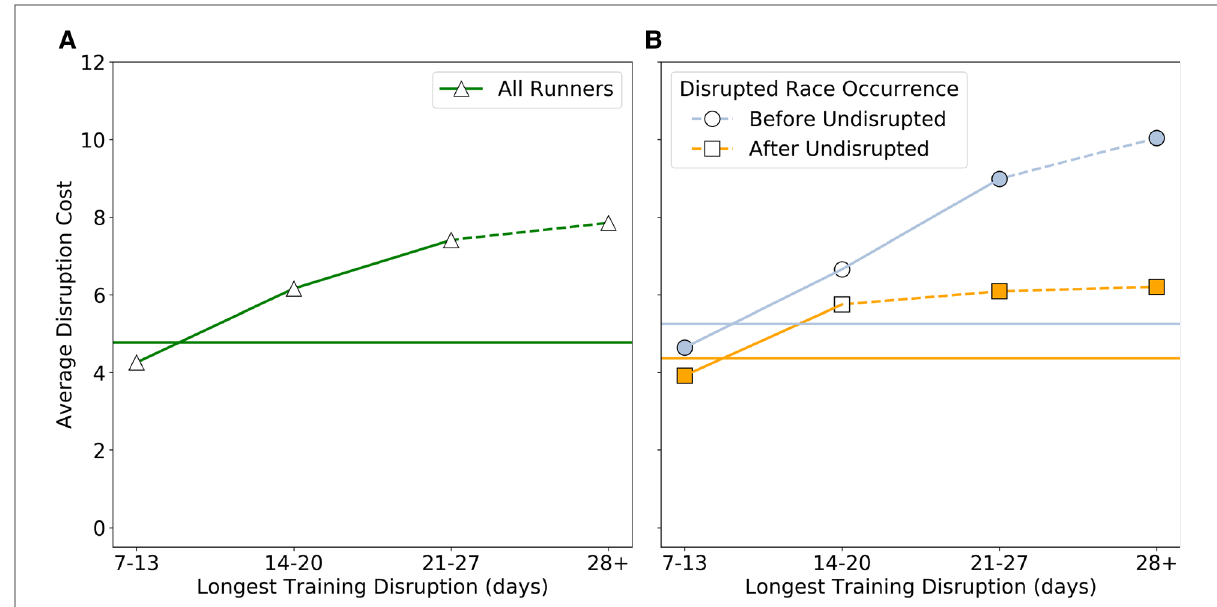
FIGURE 2 ( A ) The average disruption cost of all runners, based on the difference in marathon time for disrupted and undisrupted training periods, and the length of the longest training disruption in days. ( B ) The average disruption cost depending on whether the disrupted training programme occurs before (blue) or after (orange) the undisrupted training programme. In both ( A ) and ( B ) a solid line between markers indicates that the difference between consecutive durations of training disruptions is statistically signi fi cant based on a t test with p , 0 : 01. In ( B ) a fi lled in marker indicates for a given disruption duration a statistically signi fi cant (based on a t -test with p , 0 : 01) difference between the before and after